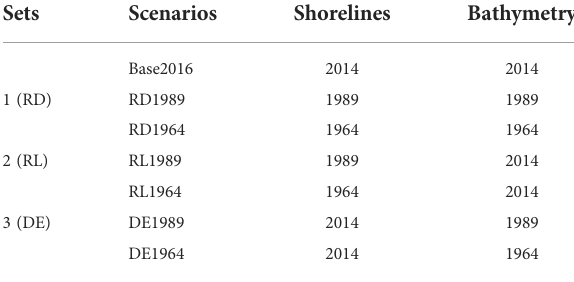
TABLE 3 Con fi gurations of coastlines and bathymetry in numerical experiments.